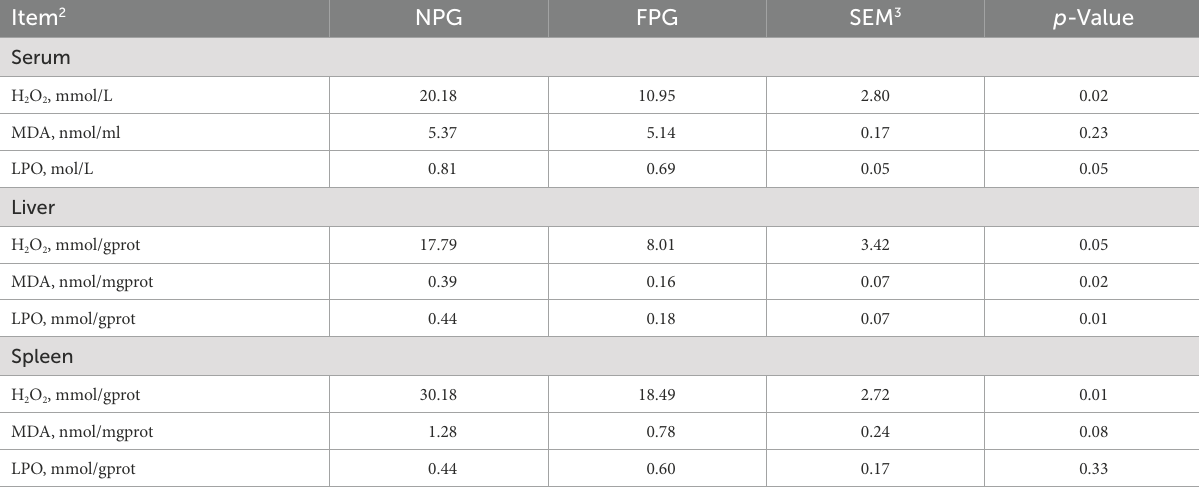
TABLE 6 Effect of fermented feed of P. giganteum on oxidant status in the serum, liver and spleen of Boer goats in thermal stress 1 .